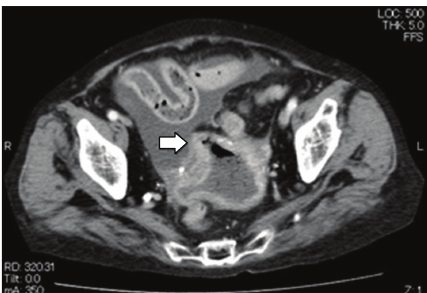
Figure1:Transverseviewofcontrast-enhancedcomputedtomogra- phy scan showing the presence of fluid within the abdominal cavity and a significantly distended fluid-filled uterus. In addition, free air was detected in the abdominal and uterine cavities. White arrow indicates the perforation site.